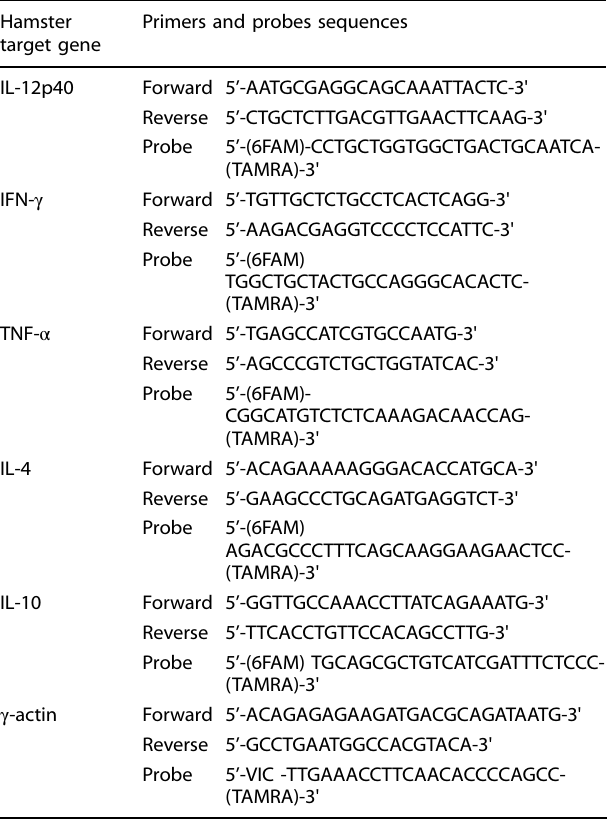
Table 1. Primers and probes used to detect expression of the